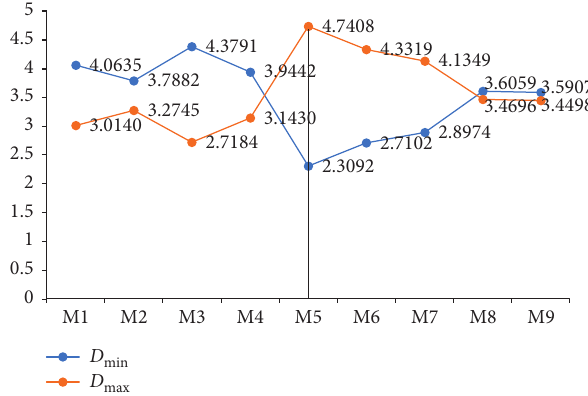
Figure 8: Visualization of the evaluation of module innovation resources at τ � 1.